Question: In a single sentence, describe what this figure presents.
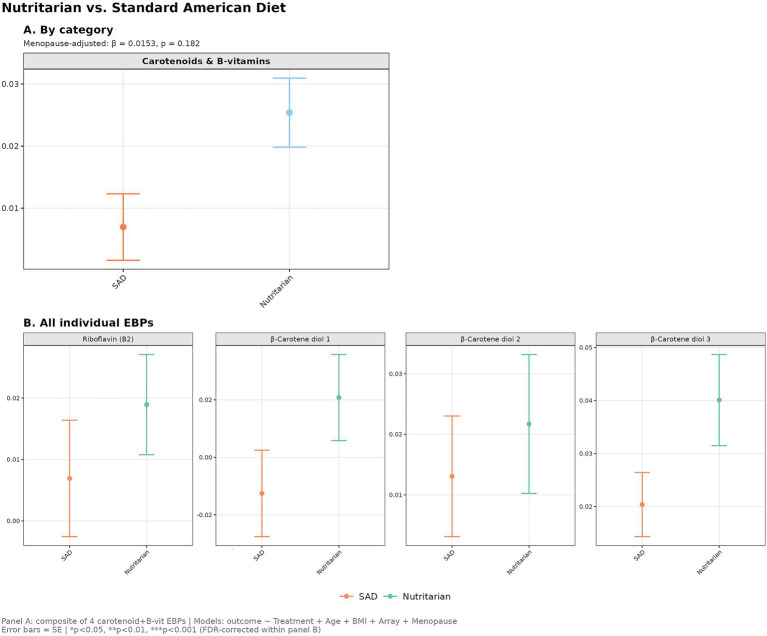
Answer: Mean intakes with standard deviations of dietary factors in nutritarian ( n = 42) and standard American diet ( n = 44) groups.